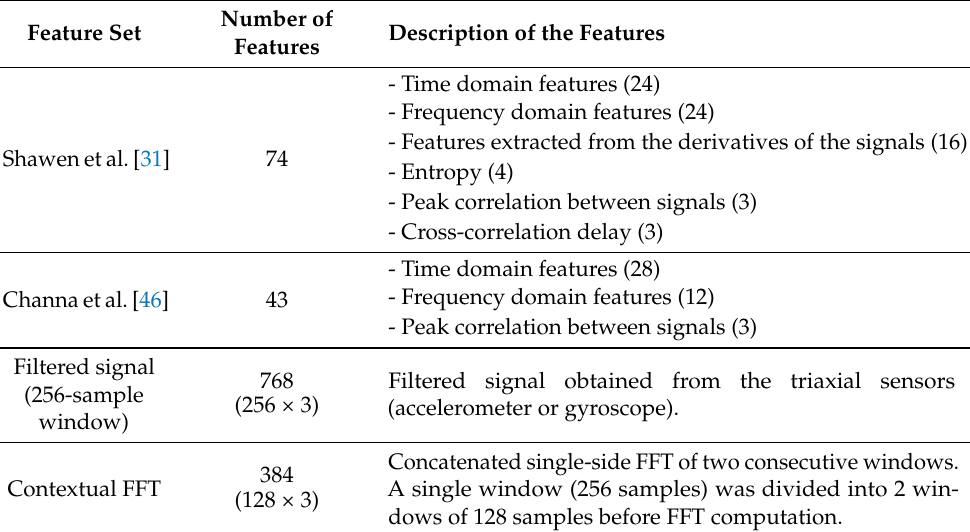
Table 1. Summary of the data representations. FFT: fast Fourier